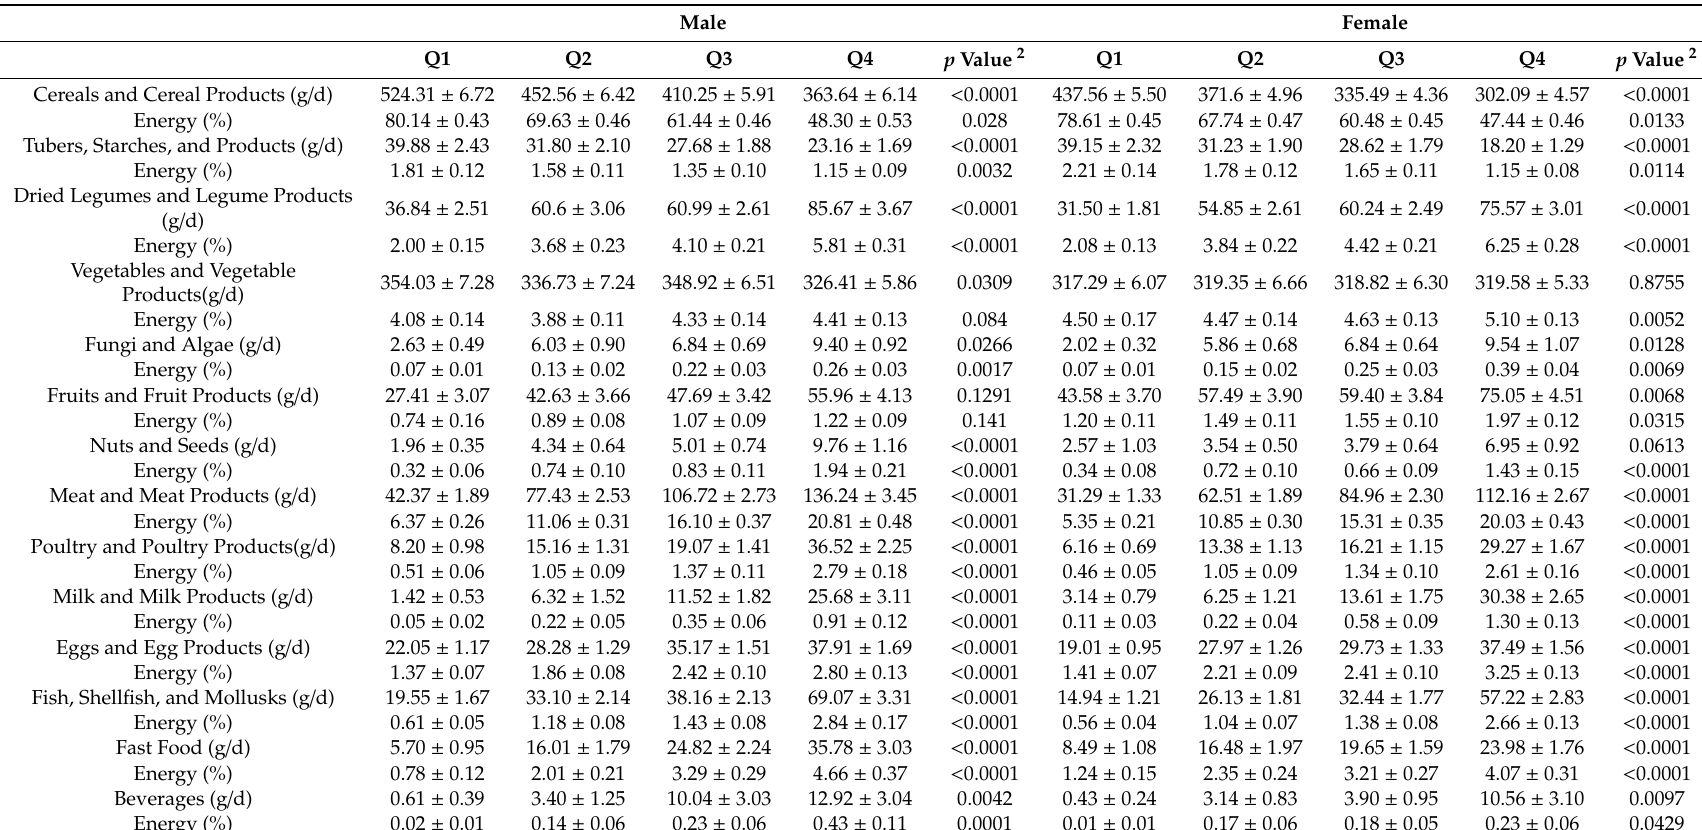
Table A1. Food intake and energy percent according to the LCD score based on gender, China Health and Nutrition Survey.